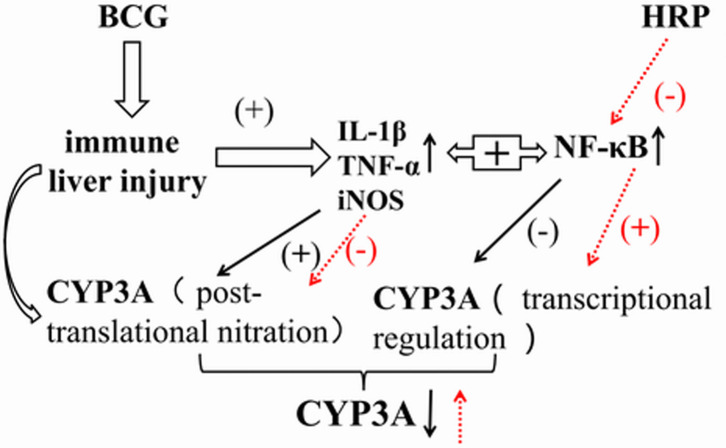
The schematic abstract of the mechanism.